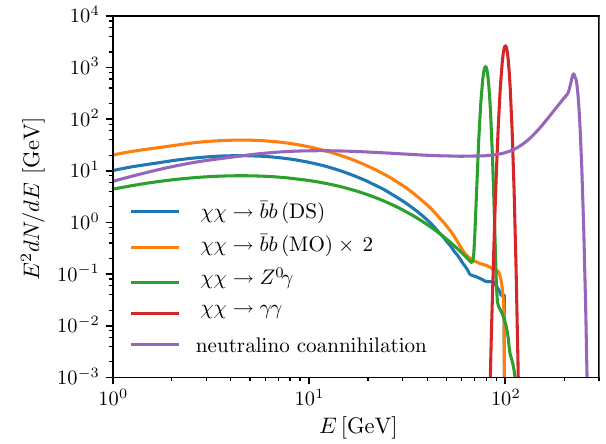
Fig. 3 Example spectra generated with DarkBit , using tabulated 2- body final states from DarkSUSY and micrOMEGAs , line-like spec- tra assuming an energy resolution of 3%, and a benchmark case from MSSM neutralino annihilation in the stau-coannihilation region. The DM mass is m χ = 226GeV (neutralino) or m χ = 100GeV (all